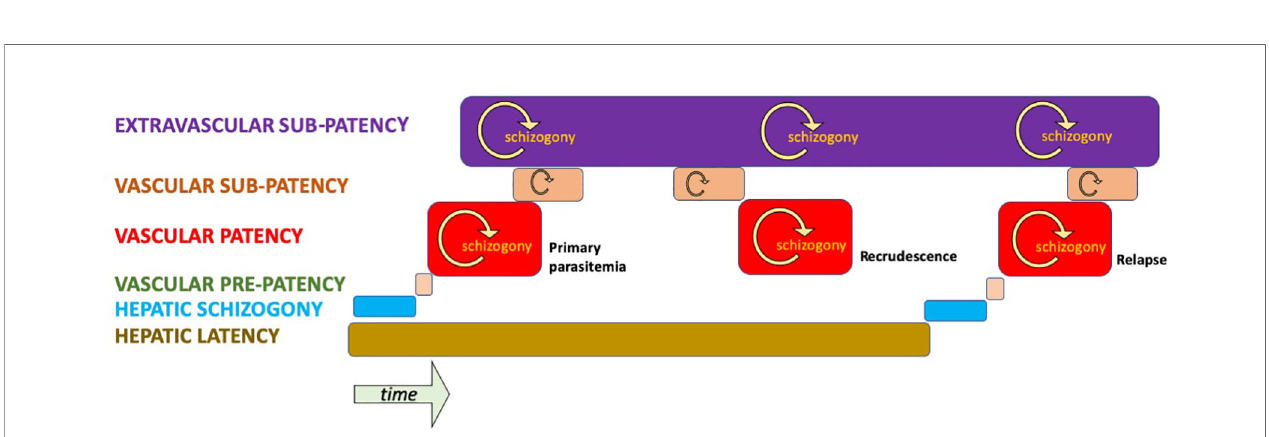
FIGURE 2 | Hypothetical distribution of equal parasite biomass (areas of the rectangles) with infection by P. vivax or P. falciparum in acutely ill patients. Tropisms of P. vivax disfavour the intravascular compartment, whereas those of P. falciparum place it predominantly within those sinuses. Estimates of parasite biomass based on counts of parasites observed in smears of peripheral blood would be disproportionately underrepresented in P. vivax malaria.